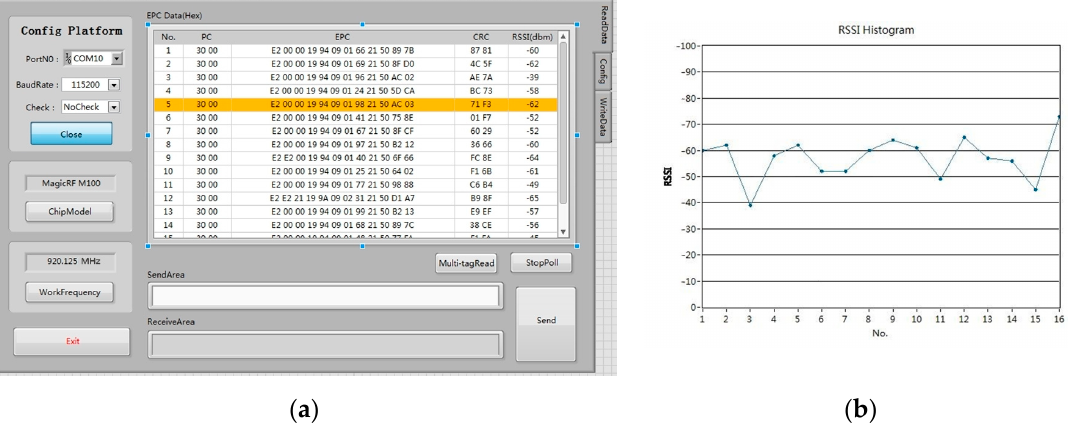
Figure 16. Test results: ( a ) Network port label data; ( b ) RSSI data analysis.